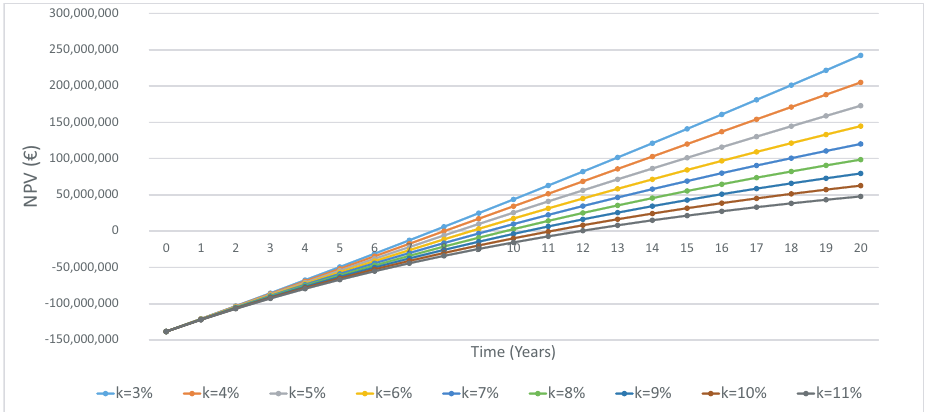
Figure 12. NPV values for different values of the rate of return in the interval between k = 3% and k = 11% and for different years of operation.